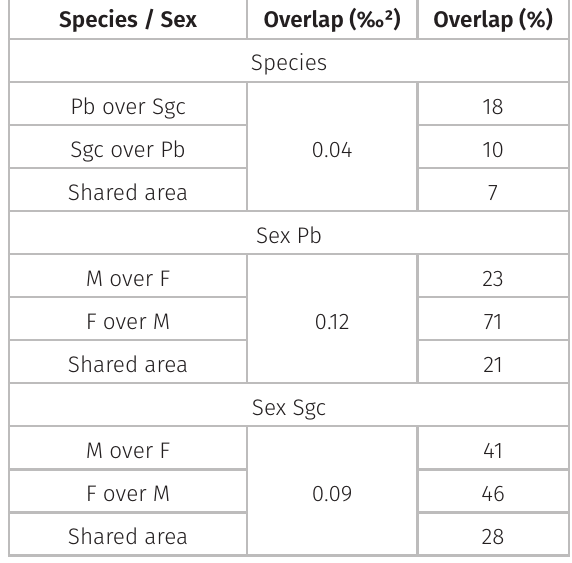
Table II. Isotopic (δ 13 C, δ 15 N) niche overlap between the standard ellipses corrected for small sample sizes (SEAc) represented in area (‰²) and percentage (%) unit of sampled Guiana ( Sotalia guianensis ; Sgc) and franciscana ( Pontoporia blainvillei ; Pb) dolphins in Southeastern Brazil from 2011 to 2018, split by sexual classes (M: male; F: